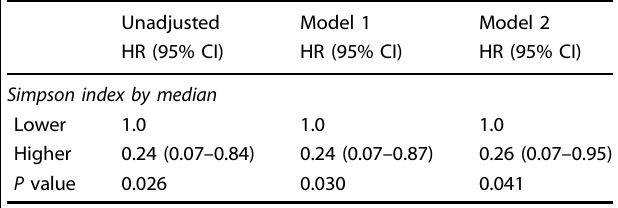
Fig. 1 Factors associated with the Simpson index. Univariate analysis of the correlation of the Simpson index with a BMI, b SGA score, c PASE score, d IL-6, and e TNF- α . Natural logarithmic transformation of IL-6 and TNF- α was used to normalize the distributions for univariate analyses. BMI body mass index, IL-6 interleukin-6, PASE the Physical Activity Scale for the Elderly, SGA subjective global assessment, TNF- α tumor necrosis factor- α . Table 2. Multivariable Cox regression analysis for the relative risk of all-cause mortality calculated for a Simpson index below or above the